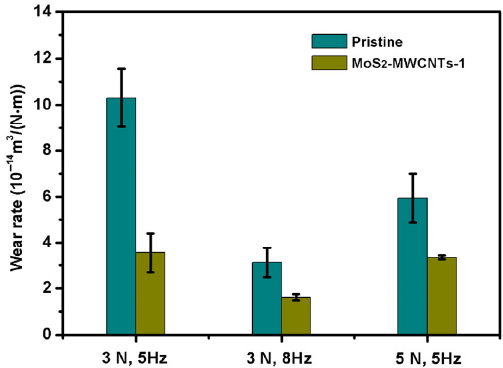
Fig. 9 Wear rates of the pristine and MoS 2 -MWCNT-1 reinforced polyurethane composite coatings under different applied loads and sliding speeds.